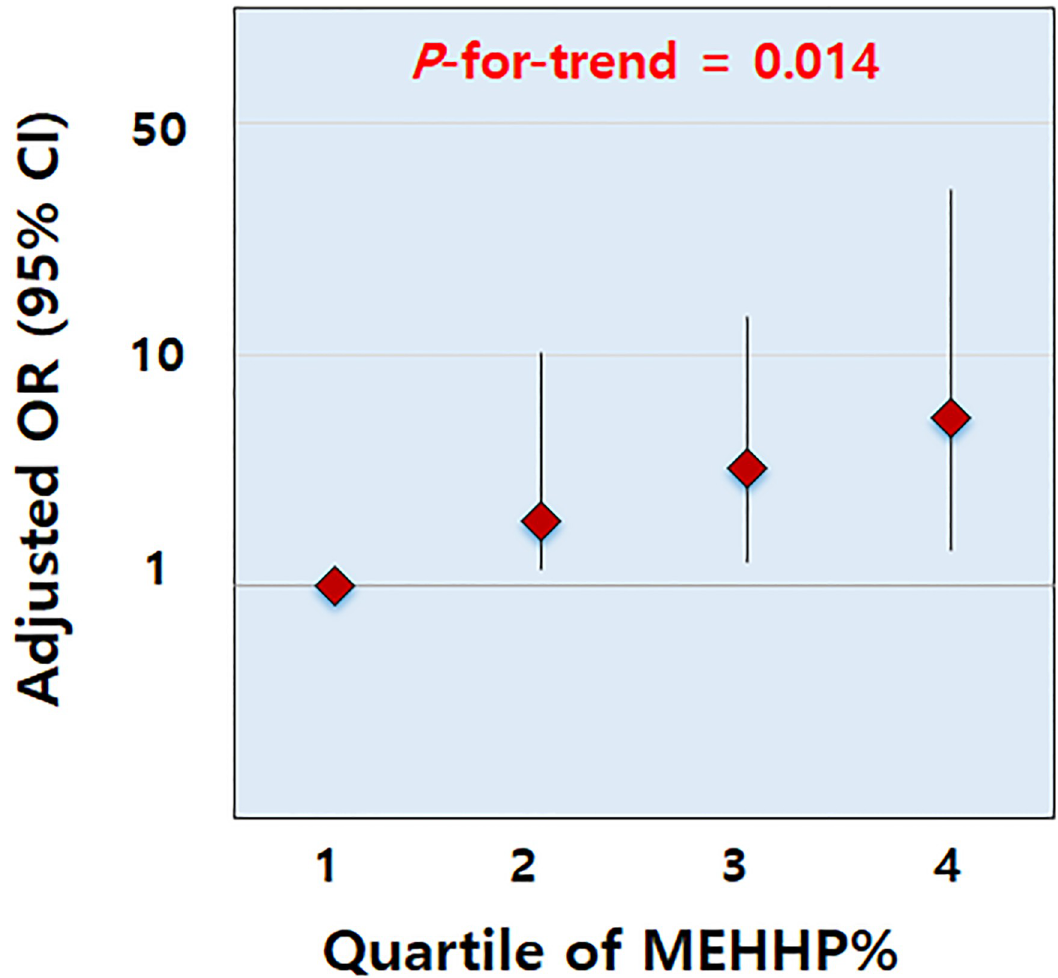
Fig 3. Adjusted odds ratios (ORs) and 95% confidence intervals for central obesity in prepubertal girls, stratified by percent fractions of mono(2-ethyl-5-hydroxyhexyl) phthalate (MEHHP%) quartiles (adjusted for age and height percentiles). The adjusted OR for central obesity significantly increased for higher MEHHP% quartiles ( P -for-trend =